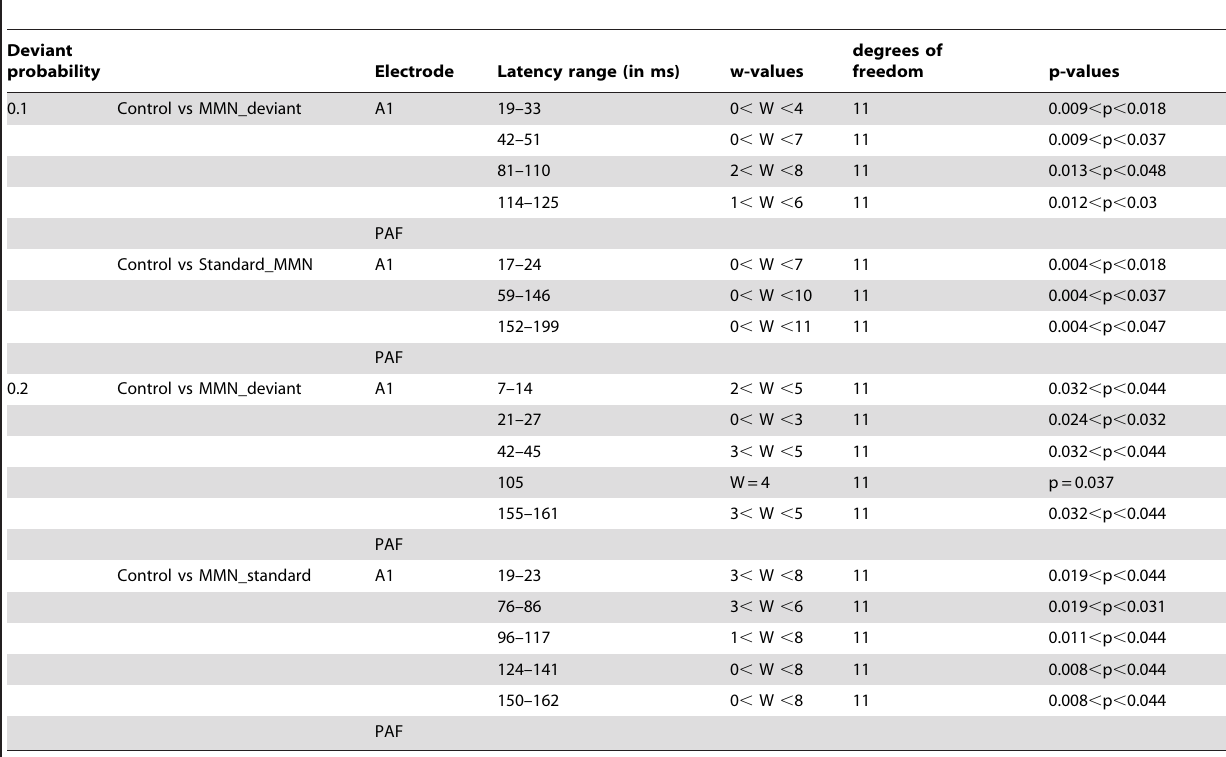
Table 4. Significant differences between the deviant in the control condition and the deviant in the oddball condition and differences between control deviant and the standards in the oddball